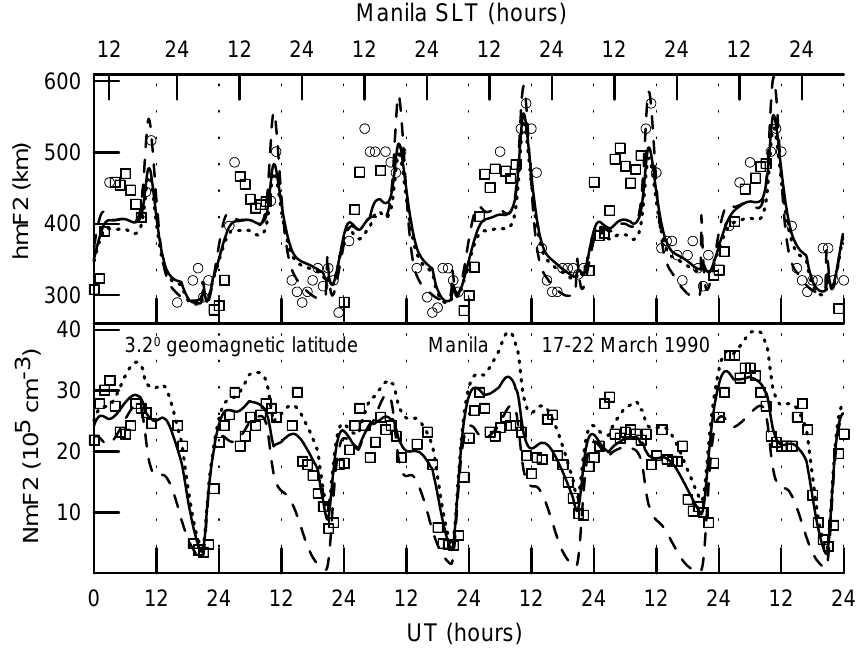
Fig. 4. Observed (squares and circles) and calculated (lines) Nm F2 (bottom panel) and hm F2 (top panel) above the Manila ionosonde station during 17–22 March 1990. The curves are the same as in Fig.